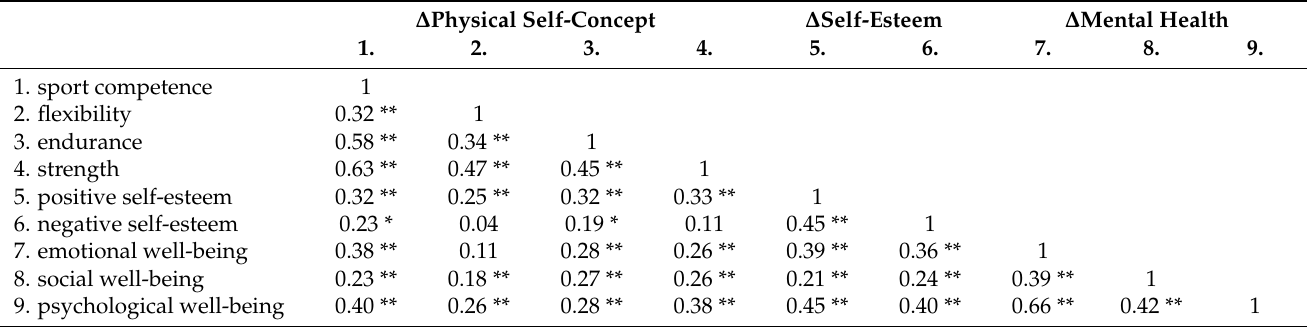
Table 2. Correlation